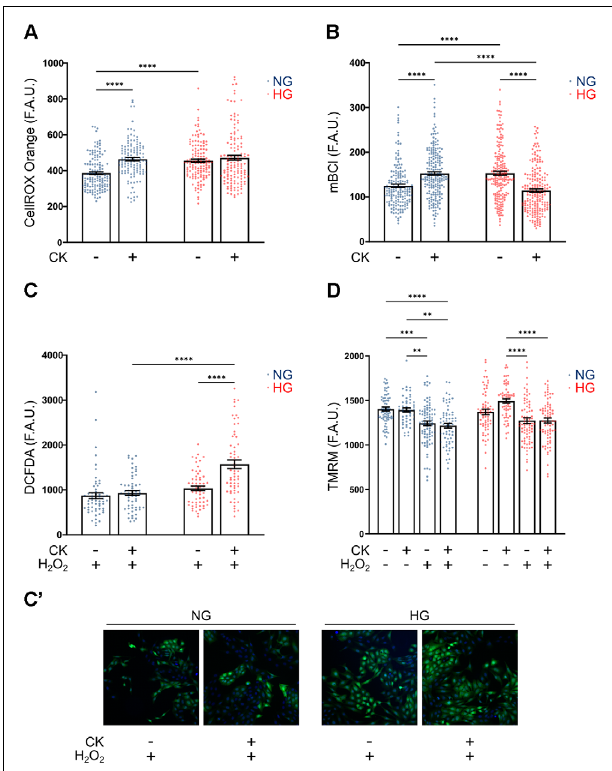
FIGURE 5 | Effect of CK treatment and oxidative stress on cellular redox state and mitochondrial membrane potential. (A) Scatter graph with bars represents CellROX Orange fluorescence values relative to ROS production in resting and CK-treated rMC-1 cells. Values are expressed as mean ± SEM of three independent experiments. Statistical significance is calculated by two-way ANOVA followed by Tukey’s post-hoc test ( ∗∗∗∗ p < 0.0001). (B) Scatter graph with bars represents mBCl fluorescence values relative to reduced glutathione (GSH) content in resting and CK-treated rMC-1 cells. Values are expressed as mean ± SEM of three independent experiments. Statistical significance is calculated by two-way ANOVA followed by Tukey’s post-hoc test ( ∗∗∗∗ p < 0.0001). (C) Scatter graph with bars represents DCFDA fluorescence values relative to ROS production in resting